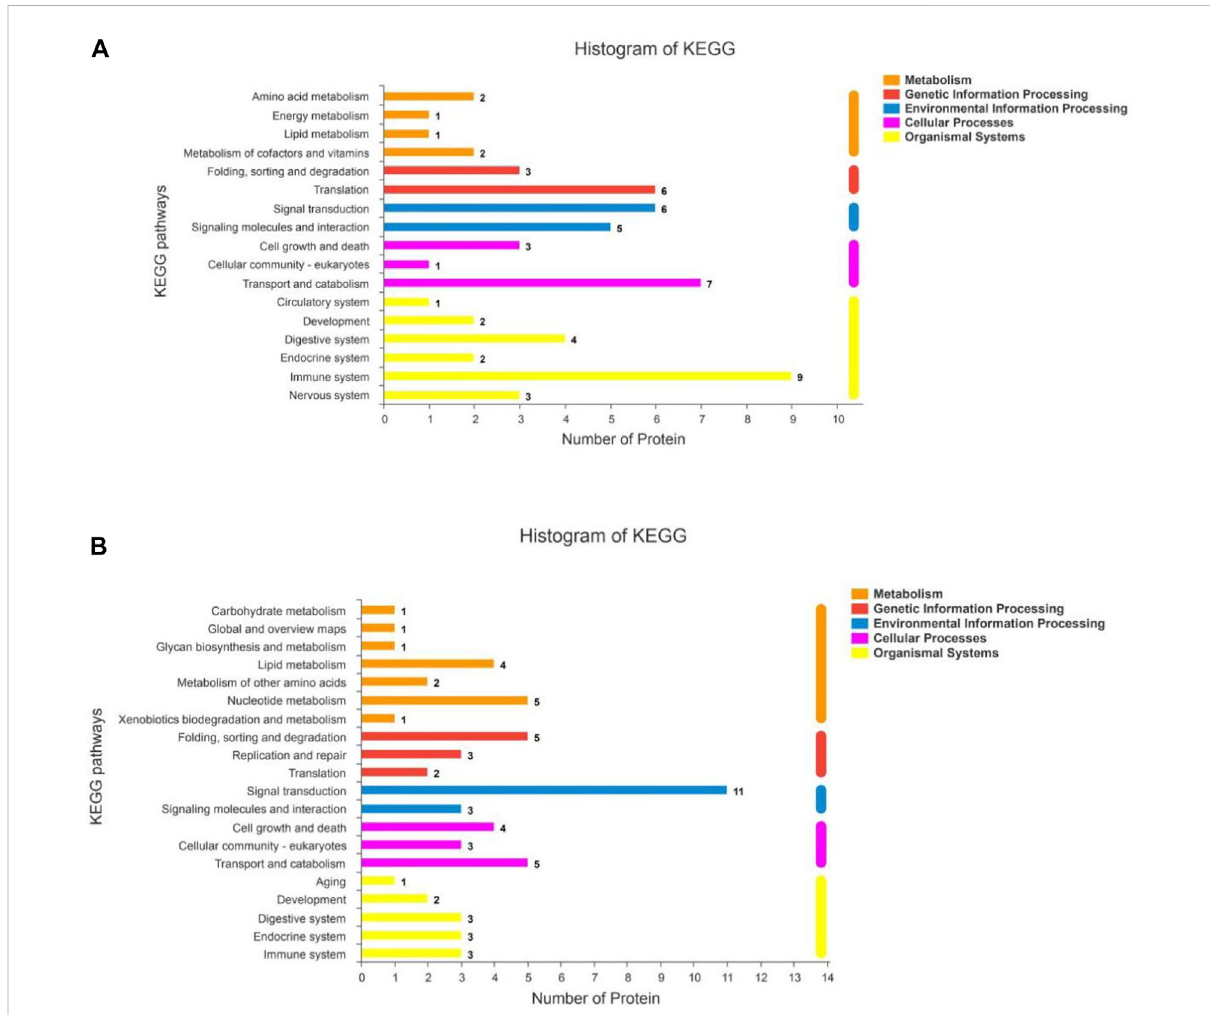
FIGURE 8 KEGG pathway analysis for DSEPs in the artemisinin group compared to the control group. (A) Upregulated DSEPs and (B) downregulated DSEPs. The ordinate is the name of the KEGG metabolic pathway, and the abscissa is the number of proteins annotated to the pathway. The bars are color-coded according to KEGG pathways, and the length of each bar corresponds to the number of proteins annotated to the corresponding